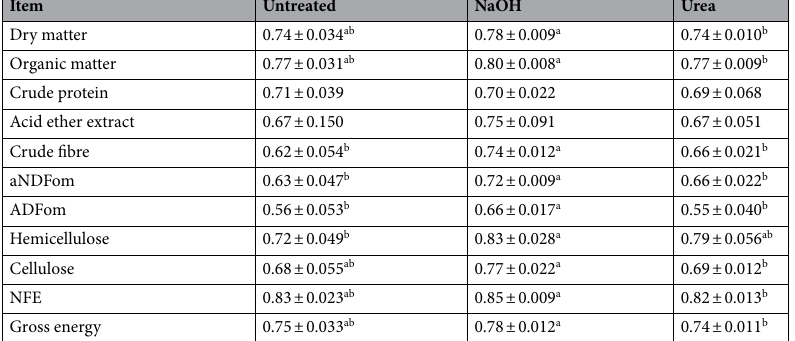
Table 6. Digestibility coefficients of dry matter, organic matter, crude nutrients, detergent fibres, and gross energy of total mixed rations including 18% untreated barley straw, NaOH treated, or urea treated barley straw. Coefficients are given as mean ± standard deviation. Treatments are specified in the text. ADFom, acid detergent fibre expressed exclusive of residual ash; aNDFom, amylase-treated neutral detergent fibre expressed exclusive of residual ash; NFE, nitrogen-free extract. ab Superscripts indicate differences among the treatments ( p <